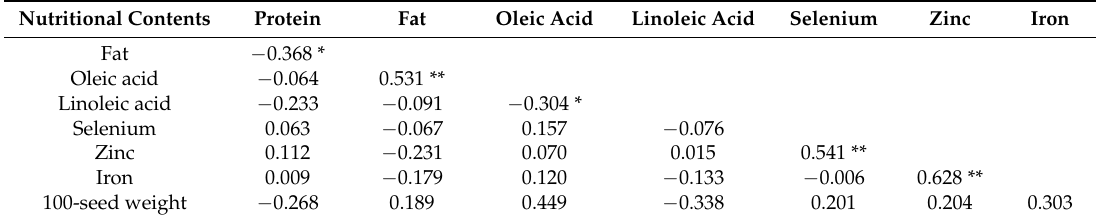
Table 1. Correlations among nutritional contents of landraces and modern varieties.